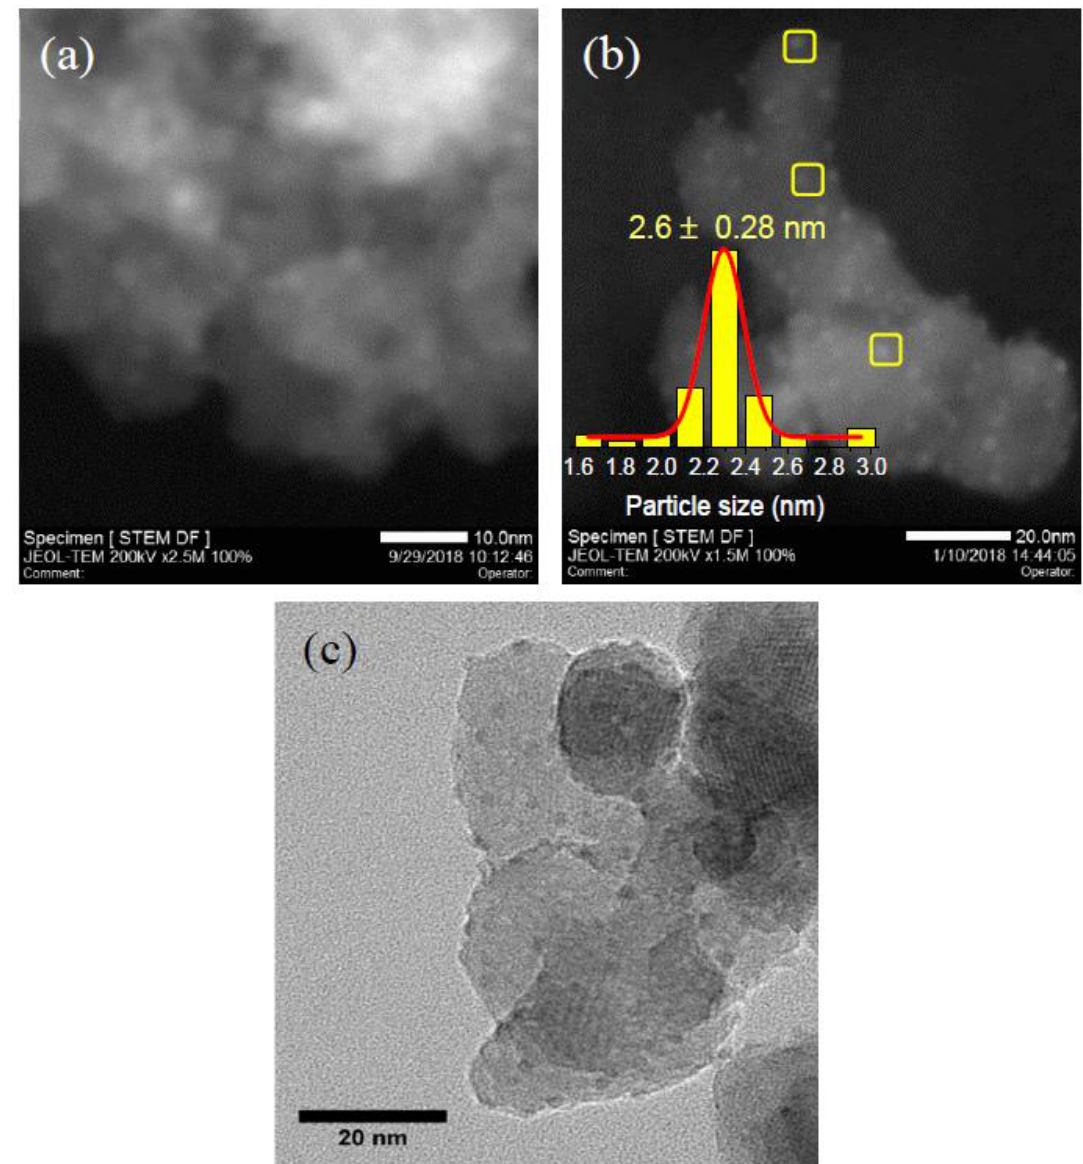
Figure 4. STEM images of ( a ) 5Ni / HAP-NP, ( b ) 10Ni / HAP-NP catalysts reduced at 500 ◦ C, ( c ) HRTEM image of 10Ni / HAP-NP catalyst reduced at 500 ◦ C yellow squares indicate respectively some typical nickel nanoparticles.